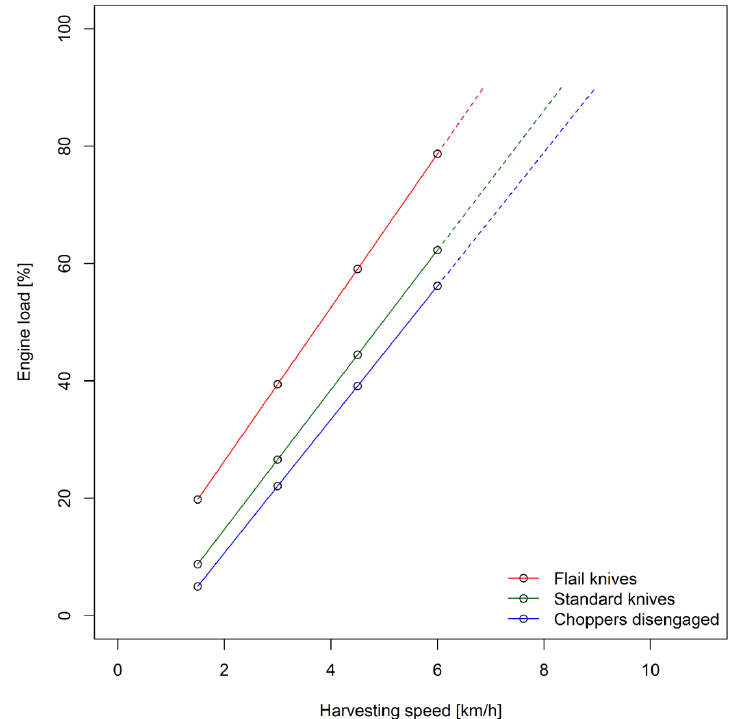
Figure A6. Percentage engine load of the combine harvester depending on harvesting speed for the levels of corn header configuration at cutting height level 2 (Markers indicate harvesting speed levels at cutting height level 2, dashed lines represent extrapolation up to a theoretical engine load of 90%).